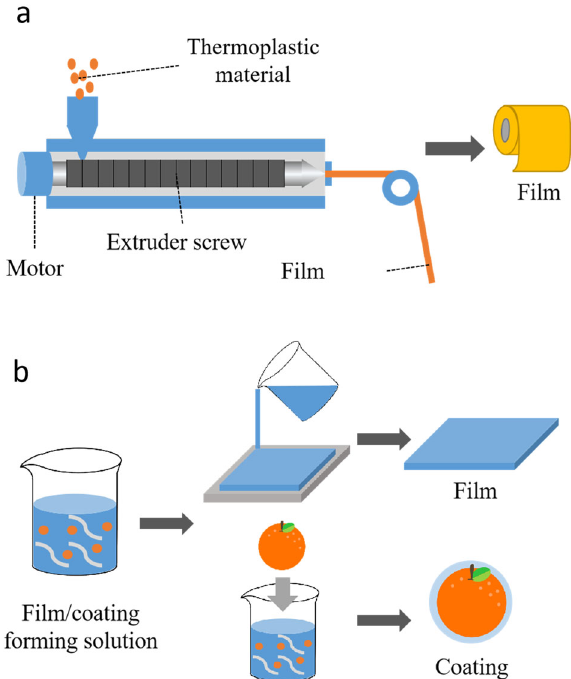
Fig. 3 Preparation of composite edible fi lms/coatings. a Extrusion. b